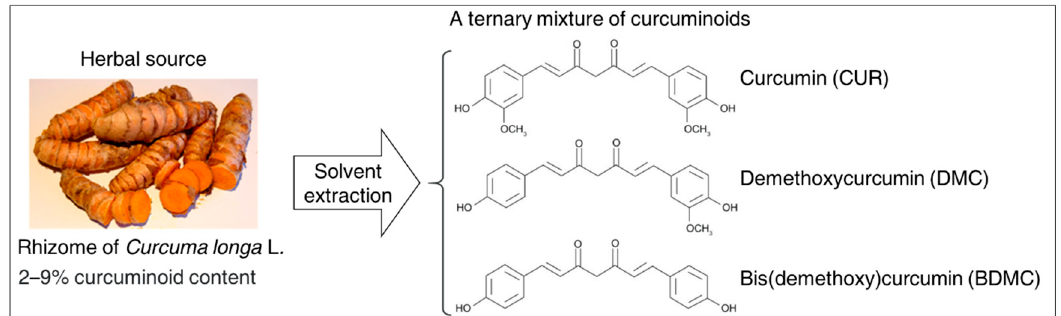
Figure 1. Curcuminoids extracted from the rhizome of Turmeric ( Curcuma longa L.) and molecular structures of the three major constituents (curcumin (CUR), demethoxycurcumin (DMC) and bis(demethoxy)curcumin (BDMC)).